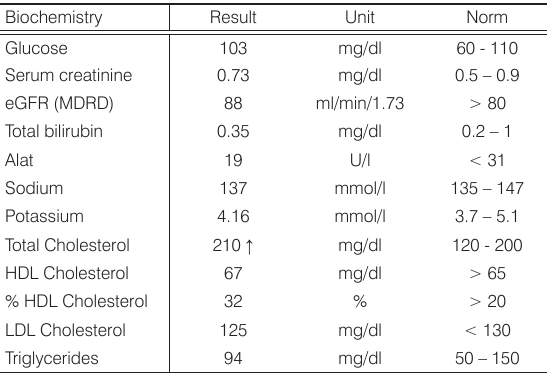
Table 2. Results of the laboratory tests – biochemistry.